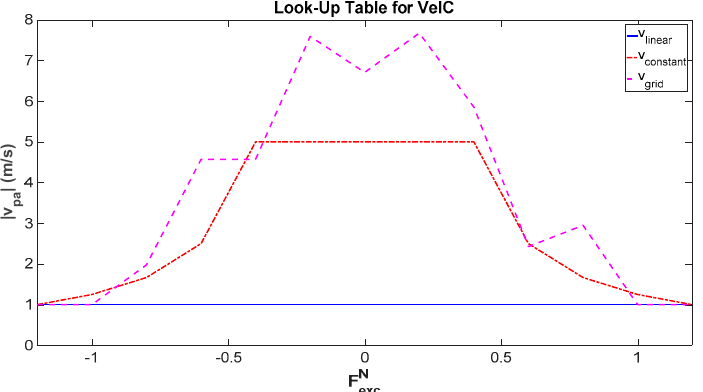
Figure 15. Optimized Look-up table, v grid , of the VelC for maximum P avg in a specific wave climate. Comparison of v grid with v linear and v constant .